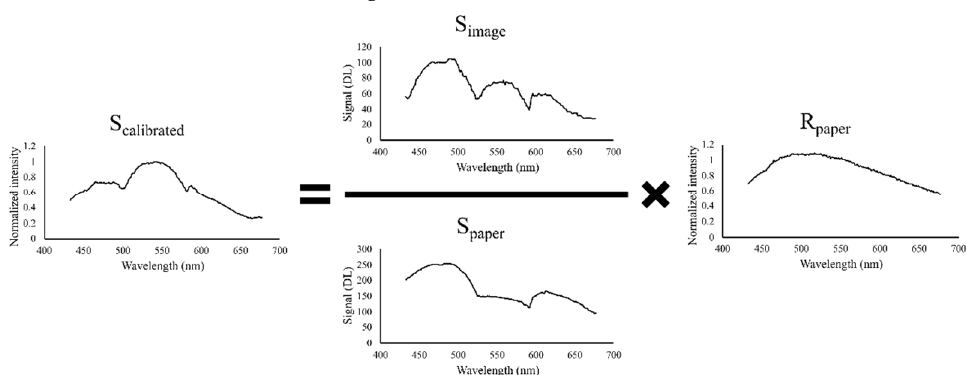
Figure 7. A graphical representation of Equation (3). The calibrated wavelength has been added retroactively for